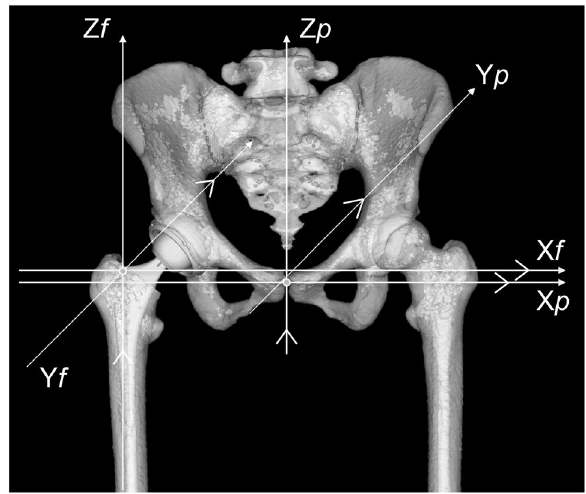
Figure 2. The three-dimensional model by ZedHip with the parallel coordinate system. The APP and RCP were parallel. The respective X,Y, and Z axes of the pelvis and femur coordinate system were made parallel. APP anterior pelvic plane, RCP retrocondylar plane.